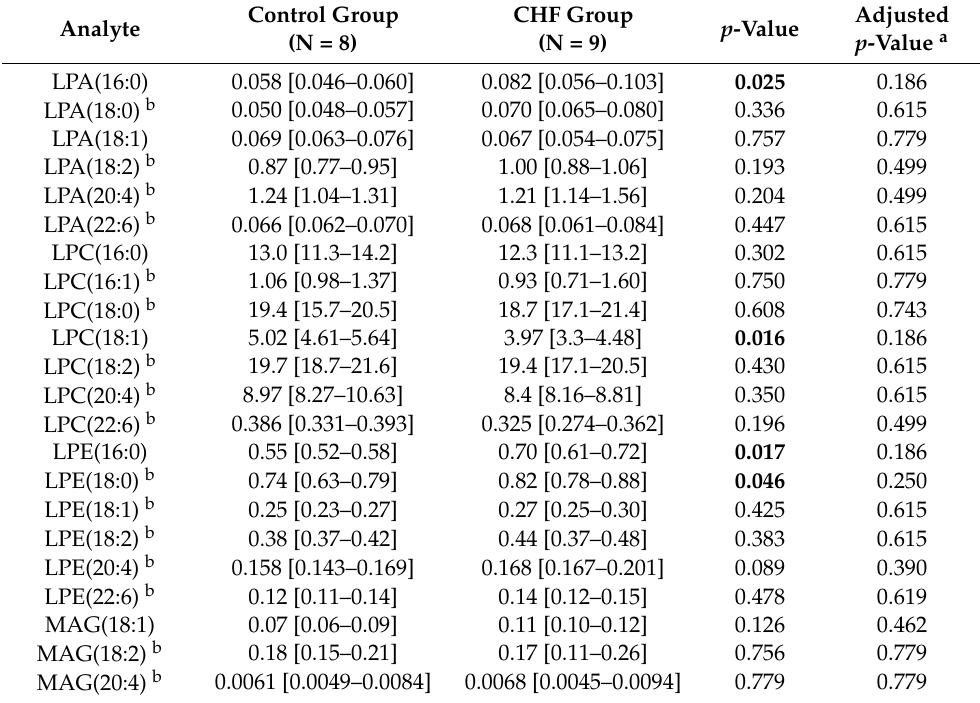
Table 2. Impact of CHF on LPA, LPL and MAG